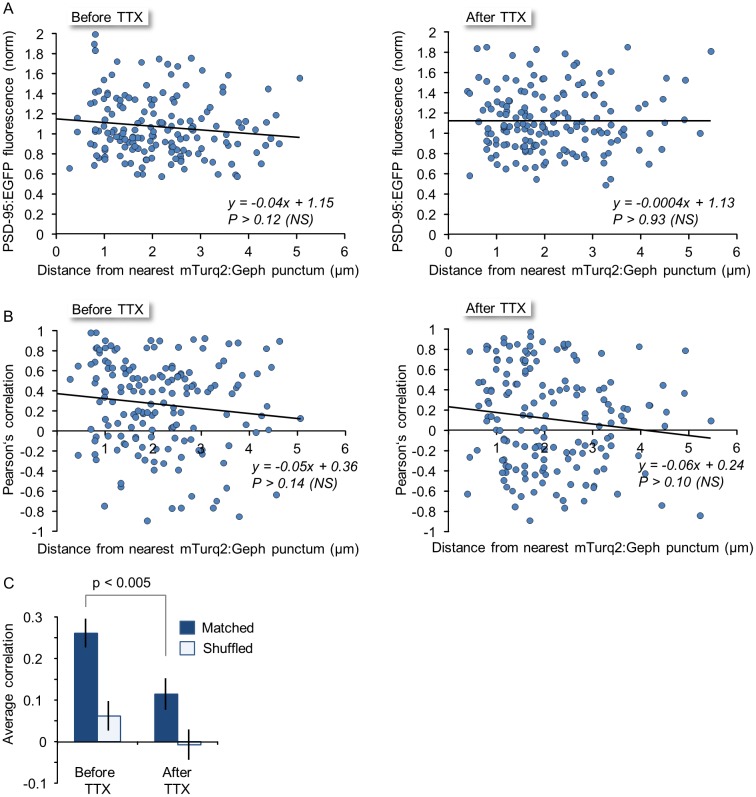
Relationships between the remodeling of nearby excitatory and inhibitory synapses.
A) PSD-95:EGFP fluorescence intensity as a function of distance from nearest inhibitory synapse before (left) and after (right) exposure to TTX. NS = non-significant. B) Covariance (Pearsons’ correlation) of PSD-95:EGFP and mTurq2:Geph fluorescence as a function of distance between the synapses before (left) and after (right) exposure to TTX. C) Average (± SEM) covariance of PSD-95:EGFP and mTurq2:Geph within groups (but irrespective of distance) before and after exposure to TTX. Same synapses as in Fig 9. Open bars (“Shuffled”) correspond to the average (±SEM) covariance calculated for all possible pairs of PSD-95:EGFP and mTurq2:Geph in the entire data set (irrespective of neuron or experiment).